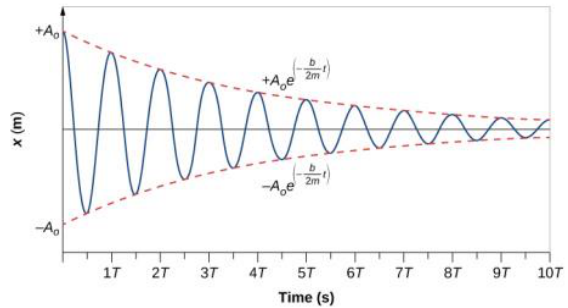
Figure 6 Underdamped Harmonic Oscillation Wave Expressing Decreasing Envelope